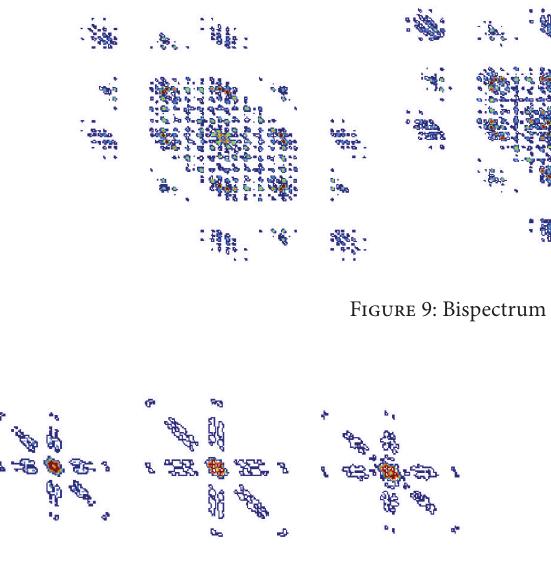
Figure 10: Bispectrum contour map of fault